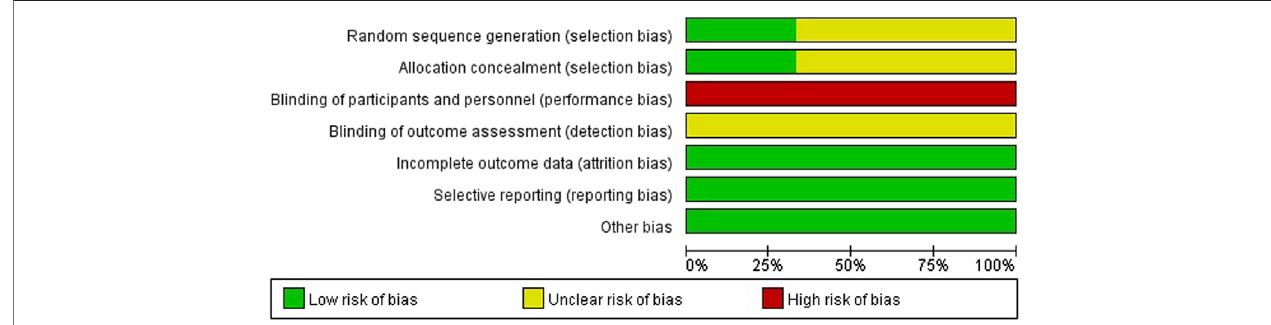
FIGURE 4 | Risk of bias summary.